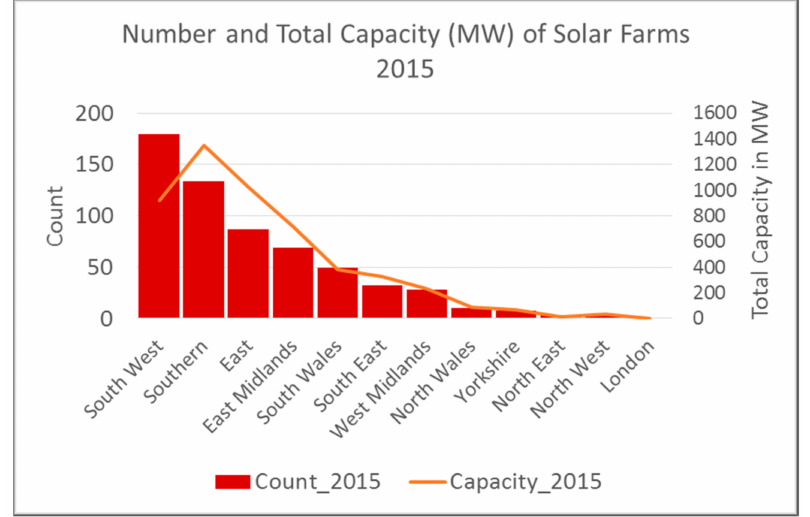
Figure 5. Number and total capacity of UK solar farms in